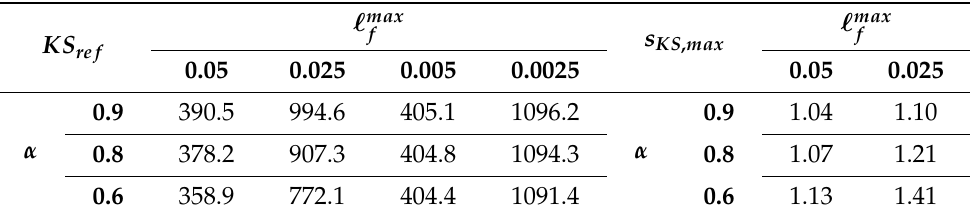
Table 1. Reference value of KS ref and s KS , max for various combination of maximal length scale (cid:96) max and material order α